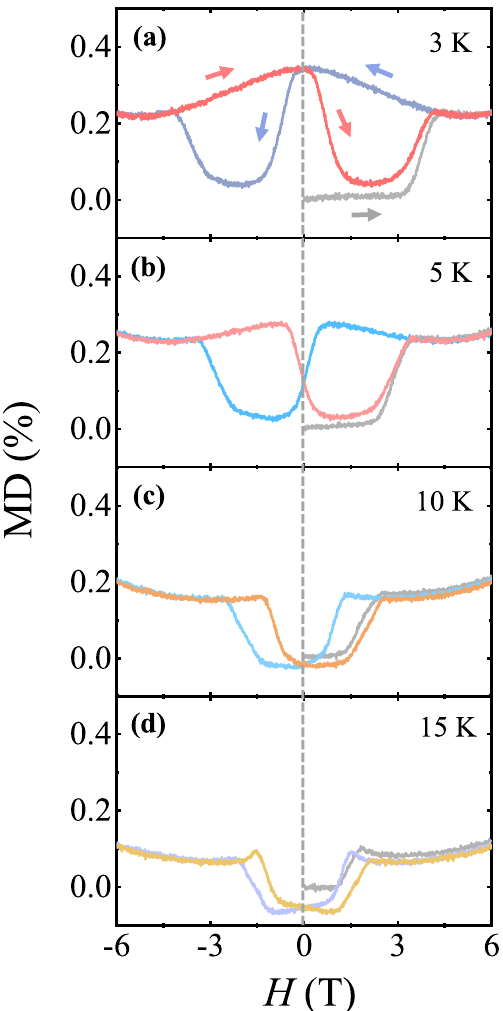
Figure 6. Temperature evolution of magnetodielectric effect along the c axis. ( a )–( d ) Magnetodielectric (MD) ′ ′ ( 0T ) ( H ) − ε × 100 , along the c axis for H up to ± 6 T along the c axis at T = 3, 5, 10, and 20 effect, MD (%) = ε ε ′ ( 0T )